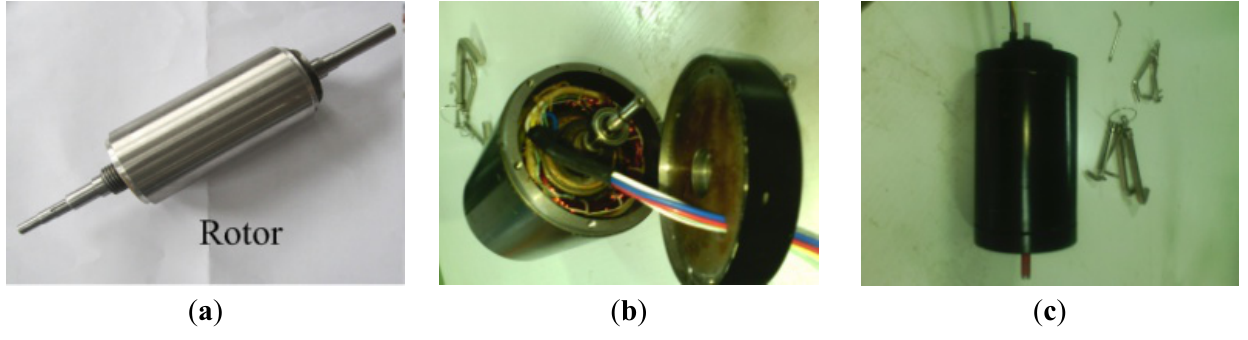
Figure 10. High speed PMSM prototype: ( a ) Rotor; ( b ) Stator; ( c ) Prototype.